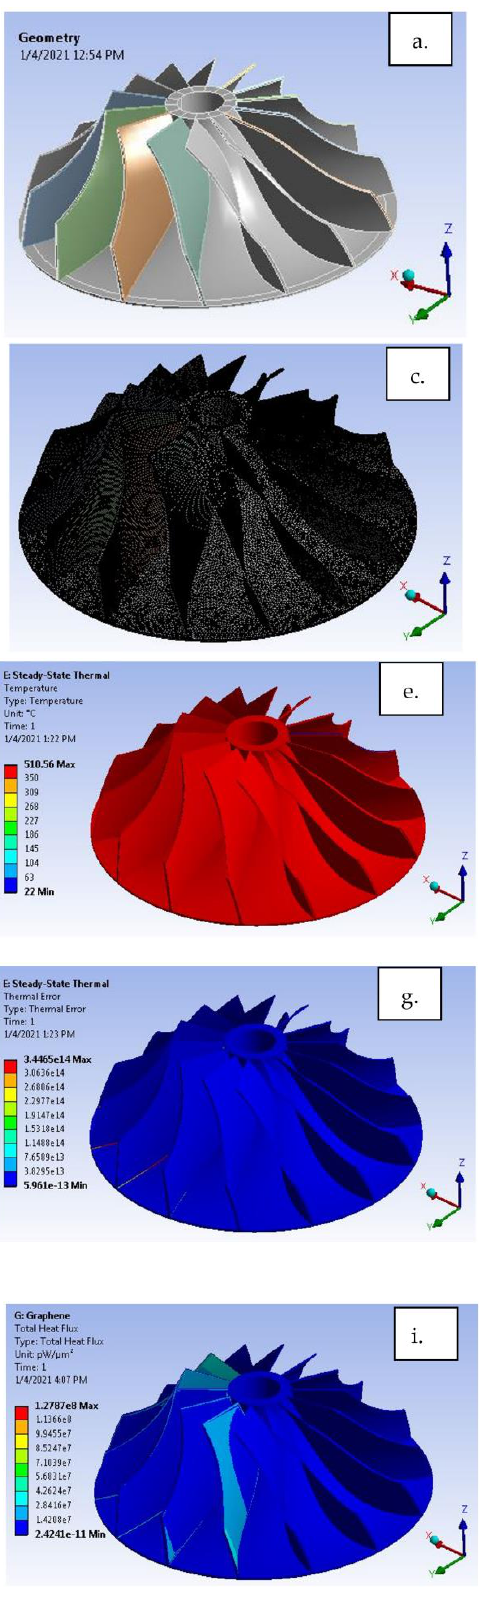
Figure 16. Compressor blade ( a ) Geometry, ( b ) Contact generation, ( c ) Mesh generation, ( d ) Loads and boundary conditions, ( e ) Temperature gradient for h-BN coating, ( f ) Heat flux, ( g ) Thermal error, ( h ) Temperature gradient for graphene coating, ( i ) Heat flux, ( j ) Thermal error. From Figure 16b, it can be inferred that ‘ Bonded ’ contact is generated between the blade and base plate as a weldment. The simulation carried out for graphene combination shows a total heat flux of 1.27 × 10 8 W/µm 2 . The temperature was raised from 500 to 510 °C for both GNP and h-BN material, making it a non-thermal material to dissipate heat comparatively higher than other thermal barrier materials currently in use. 5. Conclusions The experimental and simulation research indicated that the novel polymer compo- sites reinforced with GNP and h-BN showed better performance than plain epoxy com- posites. The main conclusions drawn follow. It was observed that an increase in filler material concentration resulted in an in- creased tensile property. Still, this nature was observed only up to 0.2 weight percent of the epoxy composite reinforced with GNP, which was followed by a gradual decrease with a higher dosage of GNP. The properties of epoxy composite reinforced with GNP and h-BN increased even at a 0.6 weight percentage. This nature may be because of the nanoparticle ’ s uniform distribution in the epoxy matrix, as shown in SEM analysis. The composite ’ s load-bearing capacity with GNP increased by 265% compared with the plain epoxy composite. The composite ’ s load-bearing capacity with GNP and h-BN increased by 219% compared with the plain epoxy composite. TGA revealed that the GNP and h-BN reinforced epoxy composite hindered the mass degradation regarding elevated temperature. The material degradation for plain epoxy composites was started at a temperature of around 242 °C. However, the material degra- dation for epoxy composites reinforced with GNP and GH was started at a temperature of around 340.99 °C and 342.43 °C, respectively. In other words, the initial 1.3% material degradation was enhanced by 40.9% and 41.5% compared to plain epoxy composite. The numerical simulation using ANSYS workbench to reach the optimal composition endorsed a small error in experiments, less than 20% error, and more than 83% confidence level. Hence, the novel proposed polymer nanocomposite reinforced with GNP and h-BN can be used for high-temperature applications around 340 °C. This composite with re- duced weight and increased mechanical strength can substitute for ceramic-based com- posites. Author Contributions: Conceptualization, M.C.C., N.R.B. and A.Y.P.; methodology, M.C.C., N.R.B., A.Y.P. and M.A.; investigation, M.C.C., A.R.J. and M.A.; resources, N.R.B., M.A.M., K.S. and M.A.; formal analysis, M.C.C., A.Y.P., A.R.J. and I.M.R.F.; validation, M.C.C., A.Y.P., A.R.J., M.A.M. and F.R.; writing — original draft preparation, M.C.C., A.R.J., T.M.Y.K., K.S. and I.M.R.F.; writing — re- view and editing, M.C.C., M.E.M.S., A.Y.P. and K.S.; supervision, N.R.B. and F.R.; project